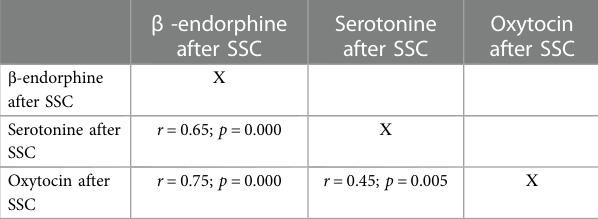
Oxytocin after SSC